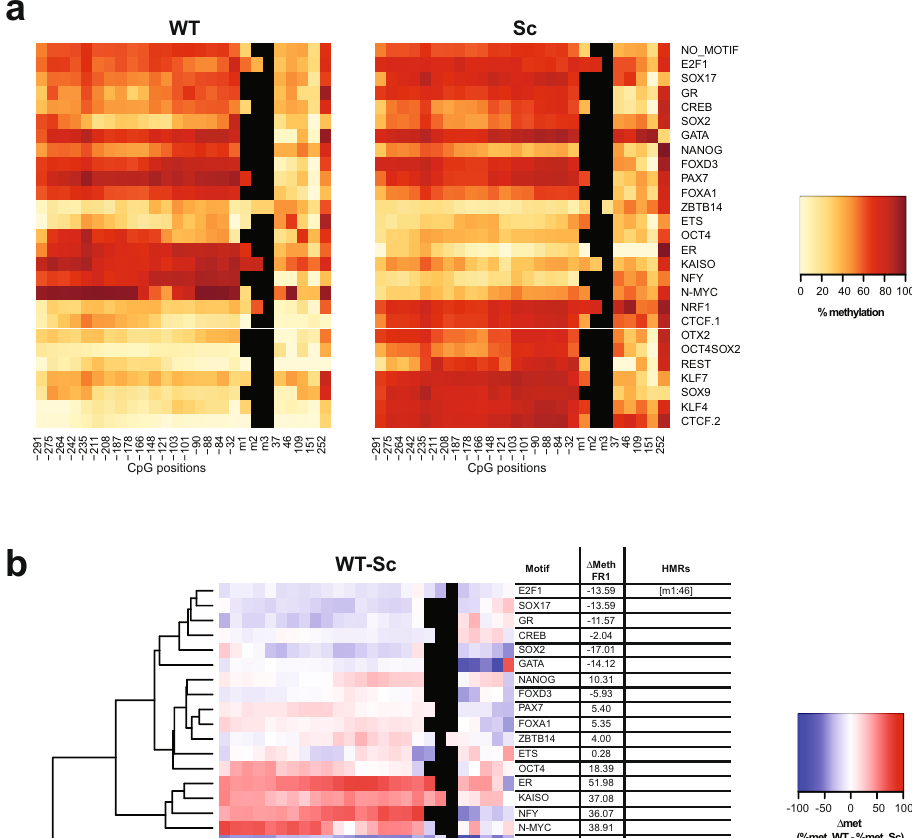
OCT4SOX2, SOX17, CREB, FOXA1 and FOXD3 as SPFs (Fig. 4f and Supplementary Table 3). SPF-dependent DNA demethylation is not suf fi cient to increase chromatin accessibility . By de fi nition, PF binding to